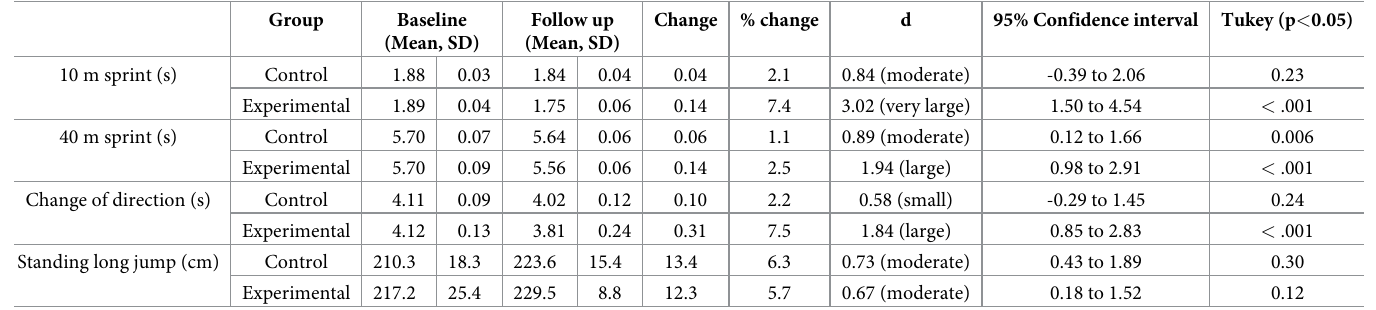
Table 2. Results of the experimental vs control